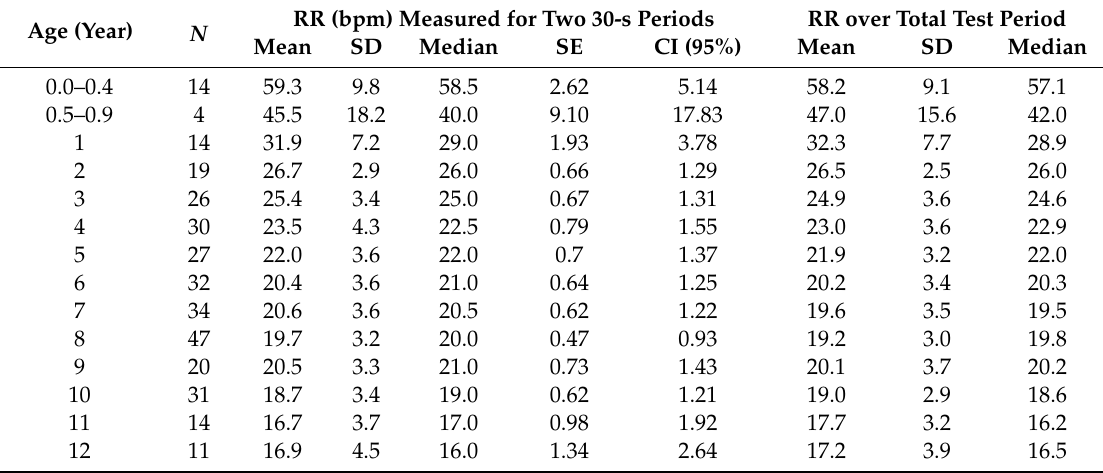
Table 3. Respiratory rate (RR) in awake healthy subjects calculated by two methods.